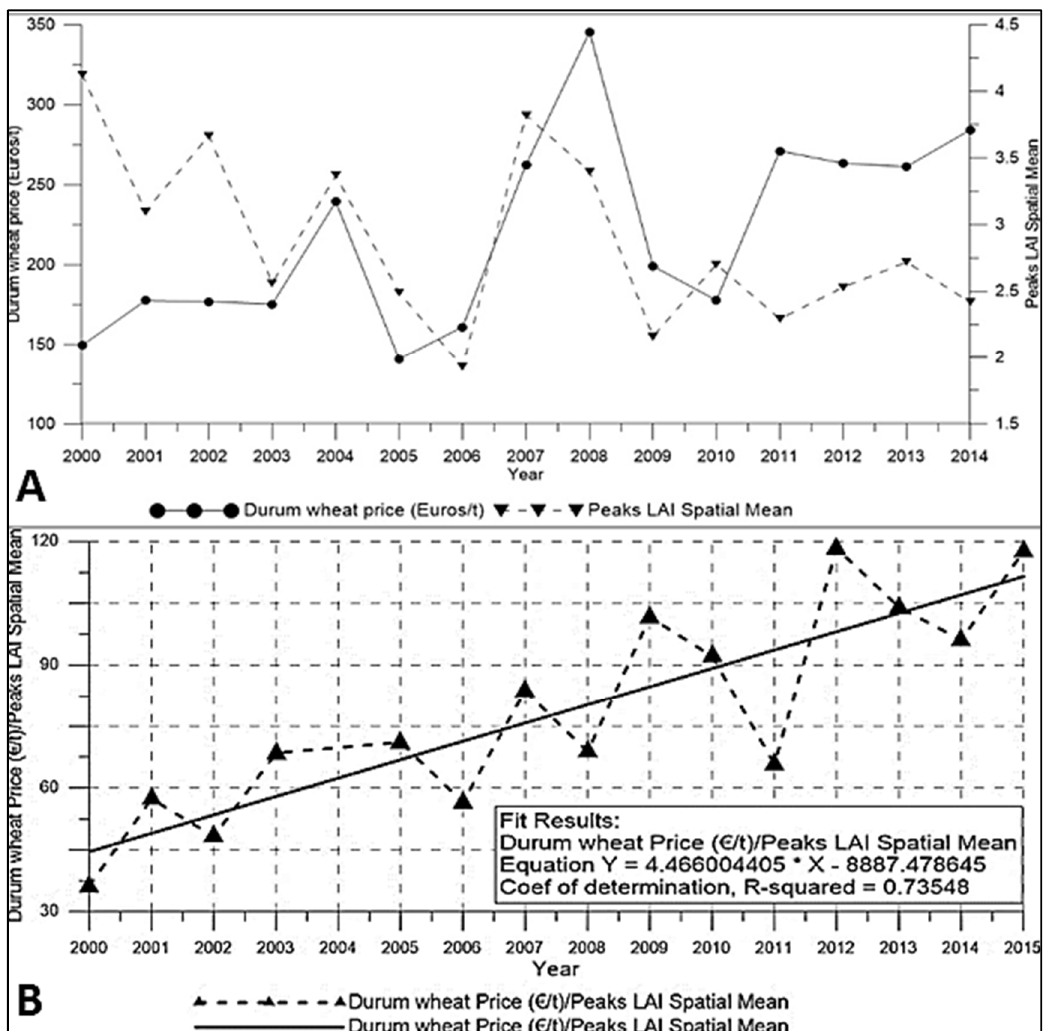
Figure 8. Annual Eurostat’s Durum Wheat Price and Peak LAI Spatial Mean variation ( A ). Annual Eurostat’s Durum Wheat Price ‐ Peak LAI Spatial Mean ratio ( B ).